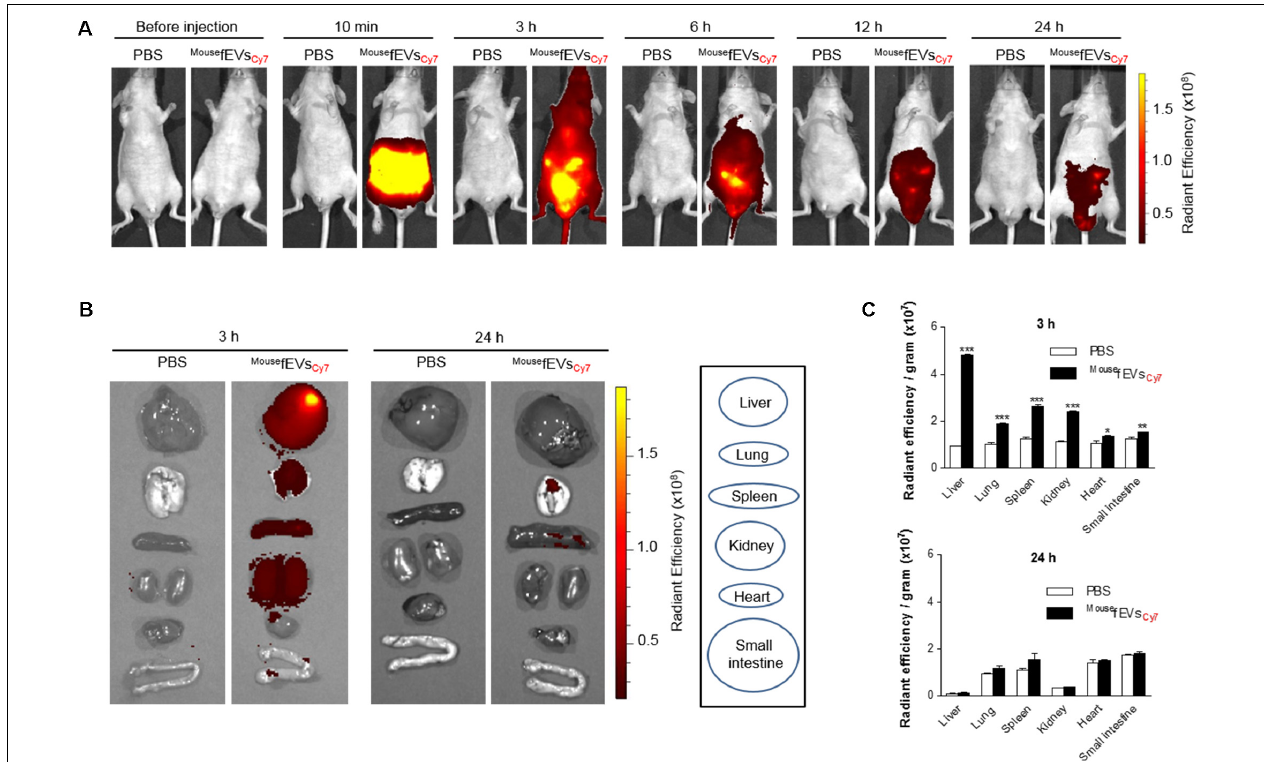
FIGURE 4 | Distribution of intraperitoneally introduced Mouse fEVs Cy7 in mice. The Mouse fEVs Cy7 (100 µ g in total protein amounts) were intraperitoneally introduced in mice. The Cy7 fluorescence of the whole body (A) or various tissues (B) was acquired by IVIS spectrum. Radiant efficiency was measured using Living Image 3.1 software, and normalized to tissue weight (C) . ∗ P < 0.05, ∗∗ P < 0.01, and ∗∗∗ P < 0.001, respectively, when the data were compared to PBS group. Error bars indicate SEM ( n =